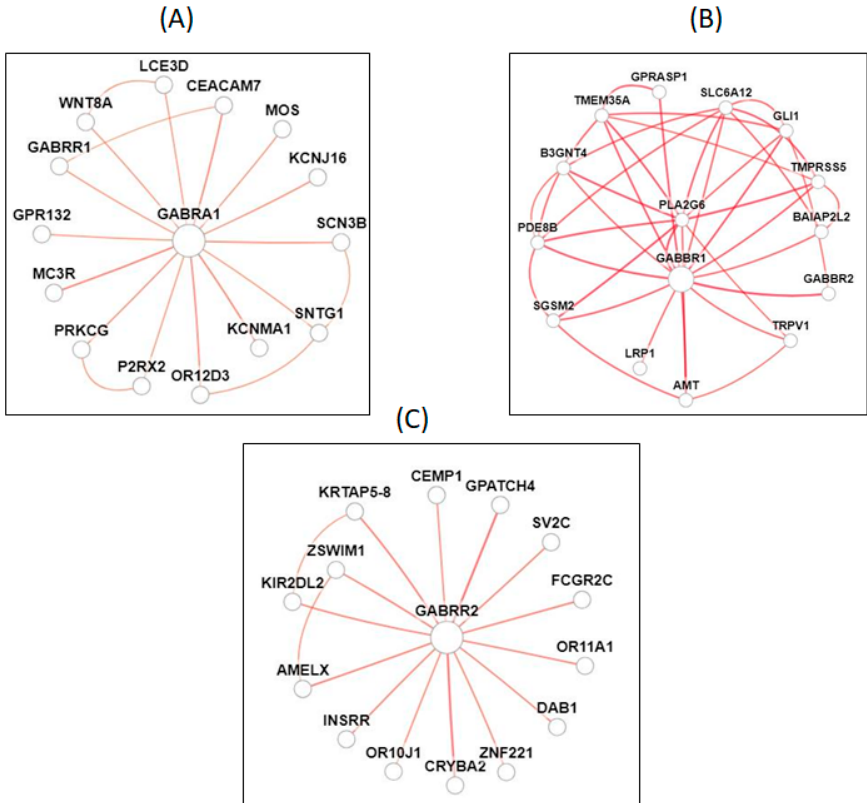
Figure 2. Potential networks of GABA receptors and association with ion channels. Panel ( A ) is the GABA receptor A 1 ( GABAR1 ) and gene networks of chloride transport genes. Panel ( B ) is GABA receptor B ( GABRB1 ) and networks of potassium transport. Panel ( C ) is GABA receptor C ( GABA-A ) and networks of chloride transport.